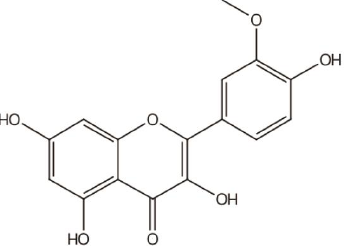
Figure 1. Basic parent nucleus of isorhamnetin glycosides (IGs).